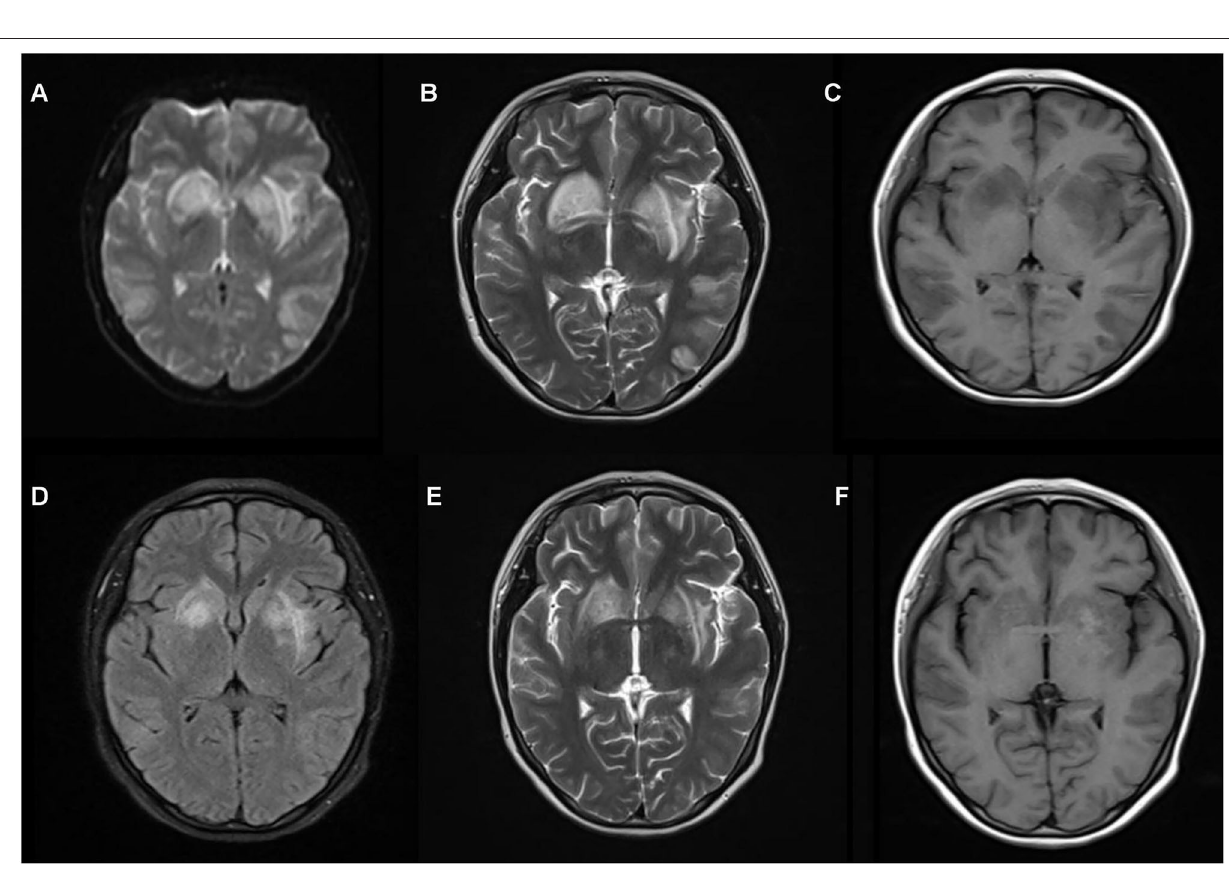
Frontiers in Pediatrics |